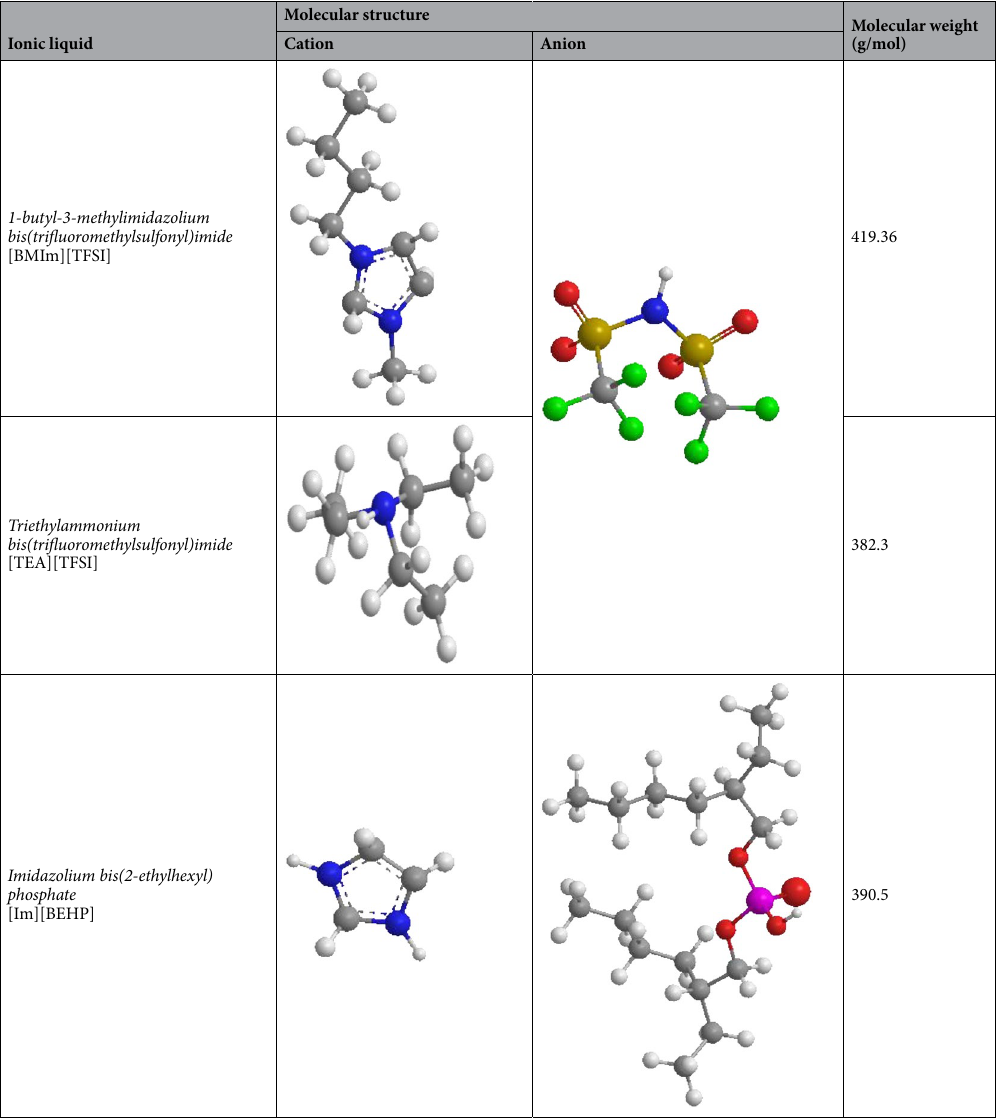
Table 1. Molecular structure and molecular weight of ILs under